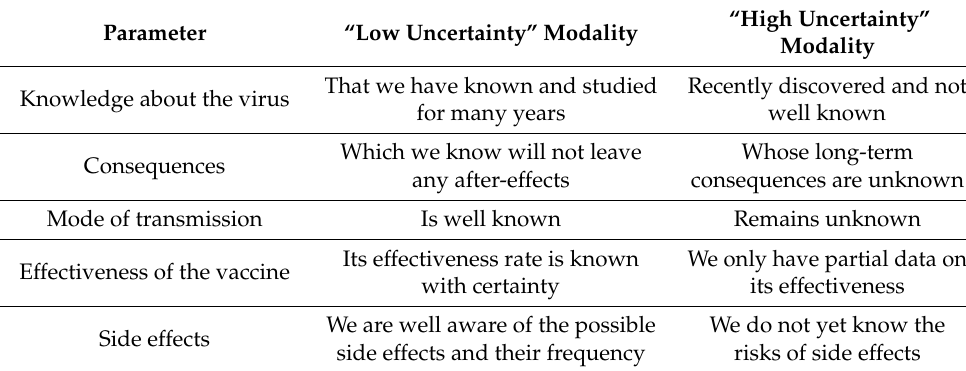
Table 1. Description of the five parameters modulating the uncertainty level elicited by the scenario through two uncertainty modalities. “High Uncertainty” Parameter “Low Uncertainty” Modality That we have known and studied Recently discovered and not Knowledge about the virus for many years well known Which we know will not leave Whose long-term Consequences any after-effects consequences are unknown Is well